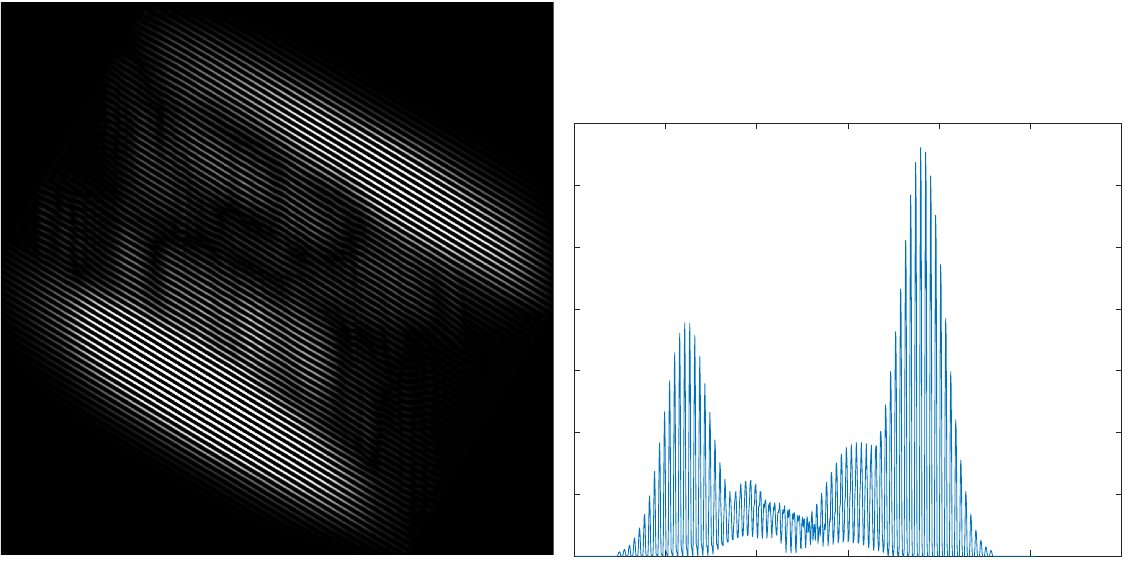
Figure 5. The Gabor feature image ( left ) and its maximum value projection ( right